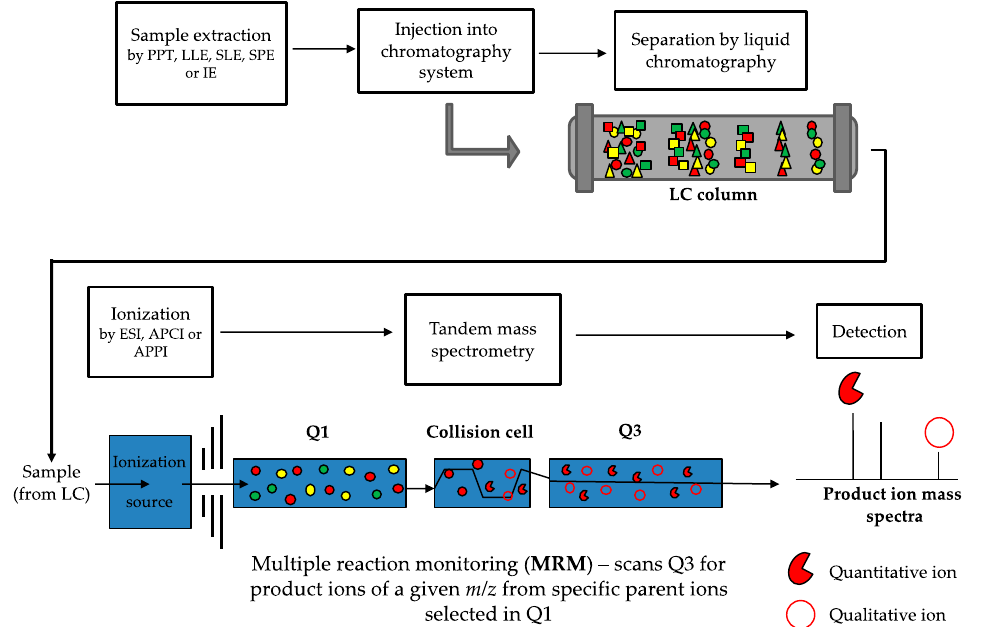
Figure 4. Workflow of LC-MS/MS method for vitamin D metabolite quantification. Samples (usually